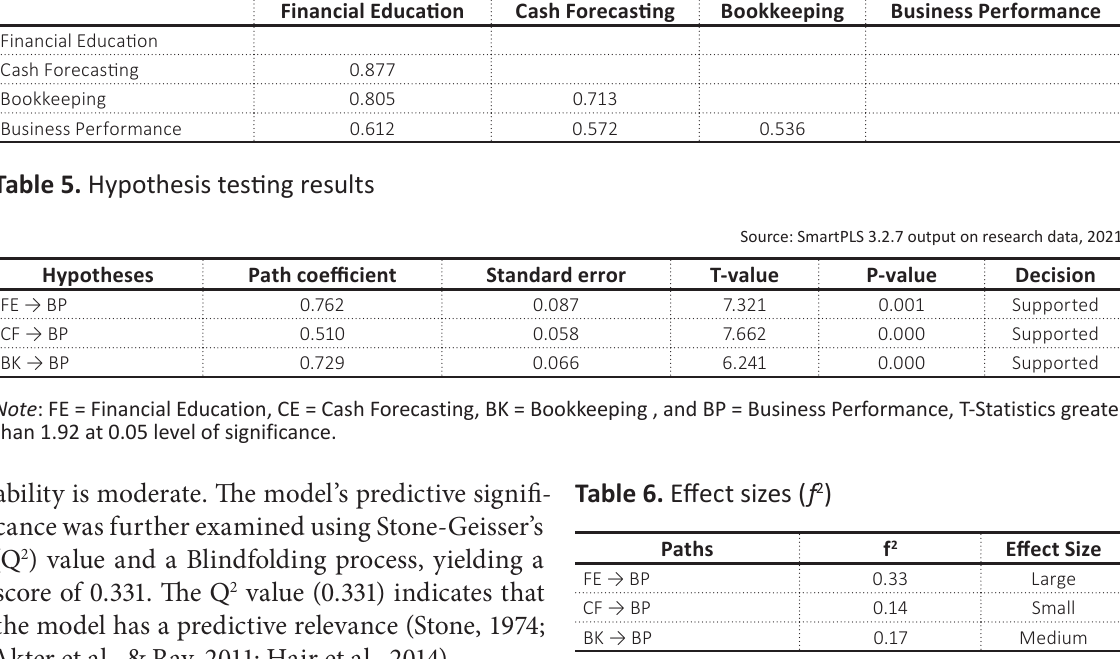
Table 4. Discriminant validity – Heterotrait – Monotrait (HTMT) criterion